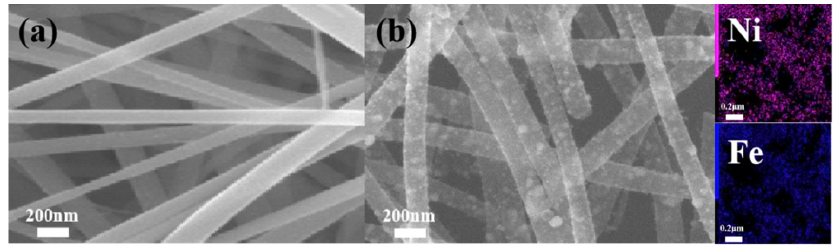
Figure 2. XRD patterns of Ni x Fe y @C-CNFs and magnified portion in the 2 θ range of 42°–48°. After mixing the nitrate solution and the PVP uniformly, the precursor of NixFey@C-